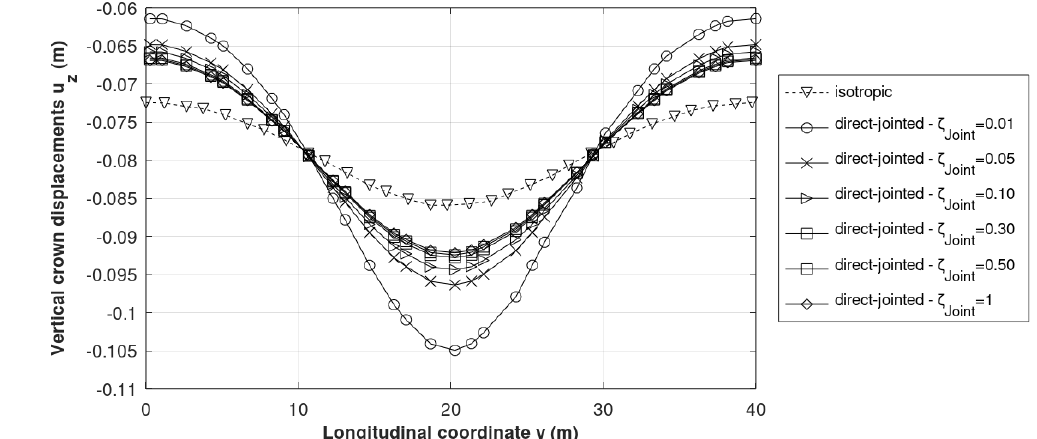
Fig. 12. Effect of shear stiffness reduction ζ